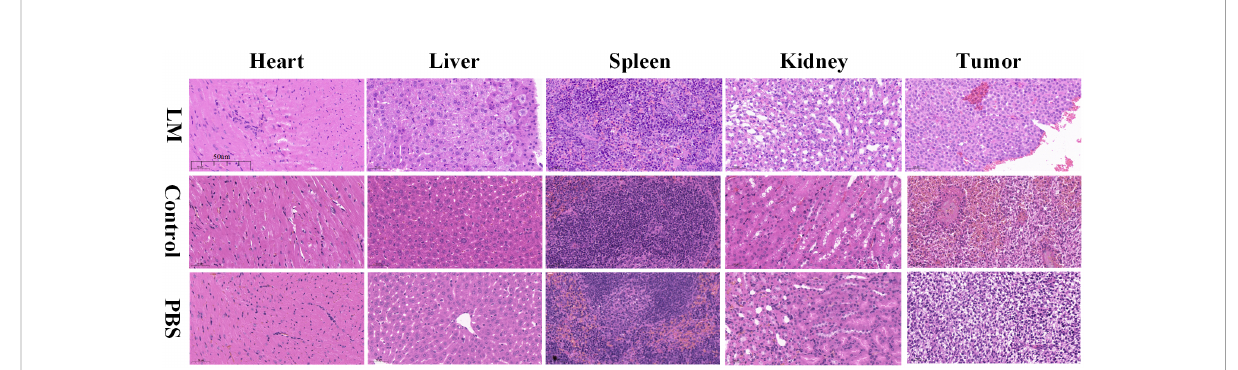
FIGURE 6 Histopathological images of important parts of tumor-bearing mice including heart, liver, spleen, kidney and tumor in each group. Resolution: 50um. LM, liquid metal; PBS, phosphate buffer saline.